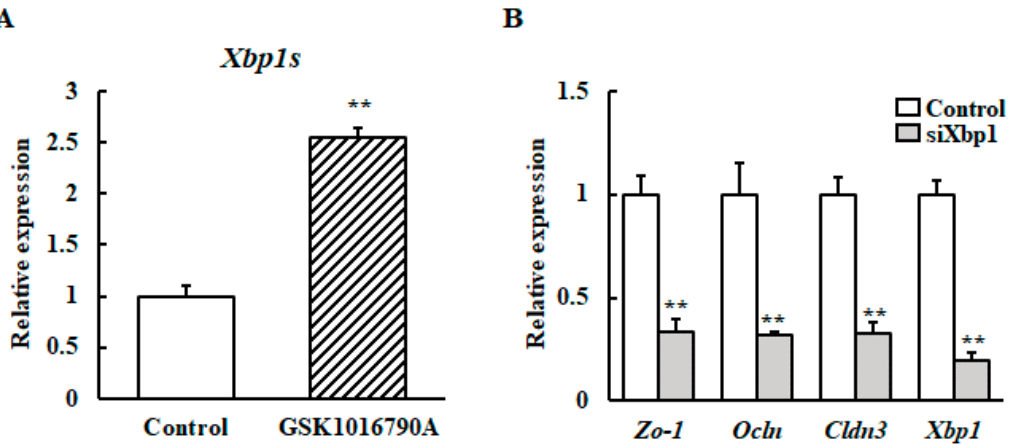
Figure 4. E ff ect of XBP1 knockdown on the mRNA expression of β -casein and the TJ protein-encoding gene after heat stimulation at 39 ◦ C. ( A ) HC11 cells were incubated at 37 ◦ C without (control) or with 10 µ M GSK1016790A for 24 h. The mRNA level of Xbp1s was detected by RT-qPCR. GAPDH was used as the reference gene. ( B ) HC11 cells were transfected with XBP1 siRNA or control scramble siRNA for 24 h. Then the cells were maintained at 37 ◦ C or exposed to 39 ◦ C without di ff erentiation medium for 72 h. The mRNA level of Zo-1 , Ocln and Cldn3 were detected by RT-qPCR. GAPDH was used as the reference gene. The results are expressed as the mean values ± SEM for four independent experiments. ** p < 0.01 compared to the control.